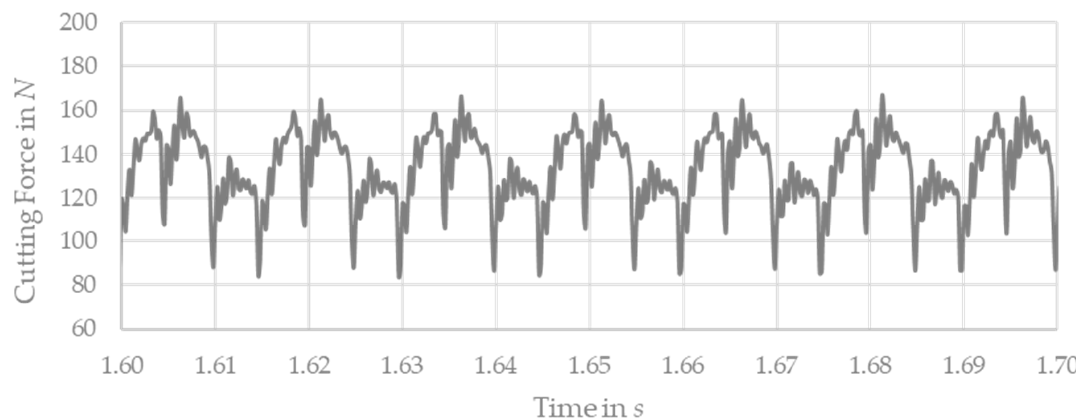
Figure 12. Force in the quasi-static range.